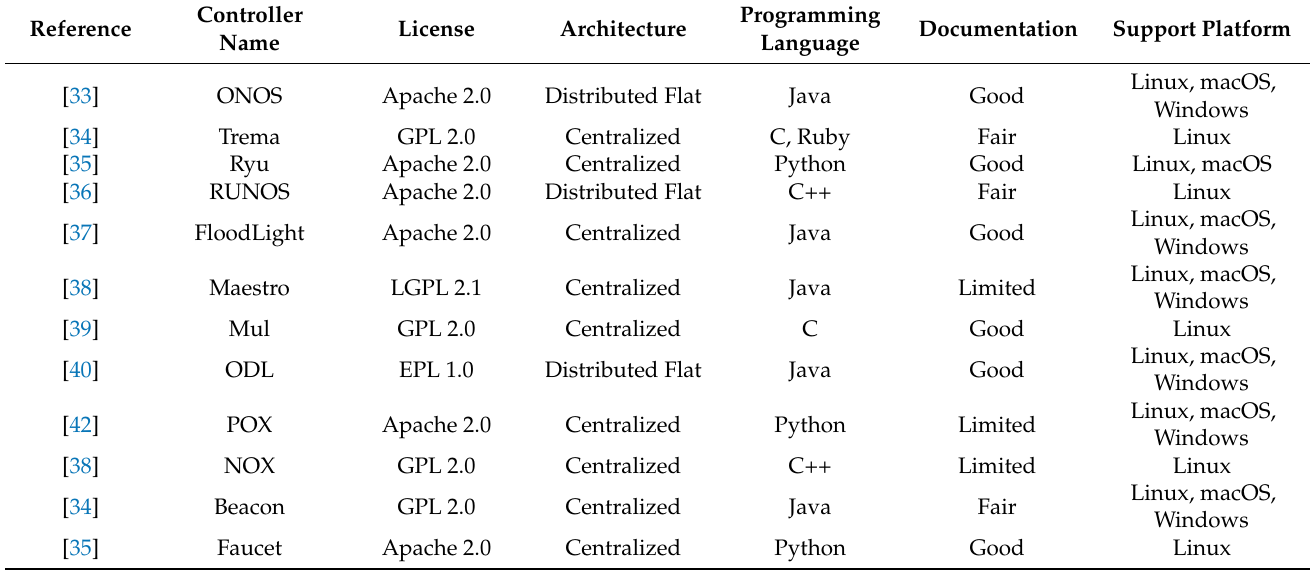
Table 2. Controller platform.